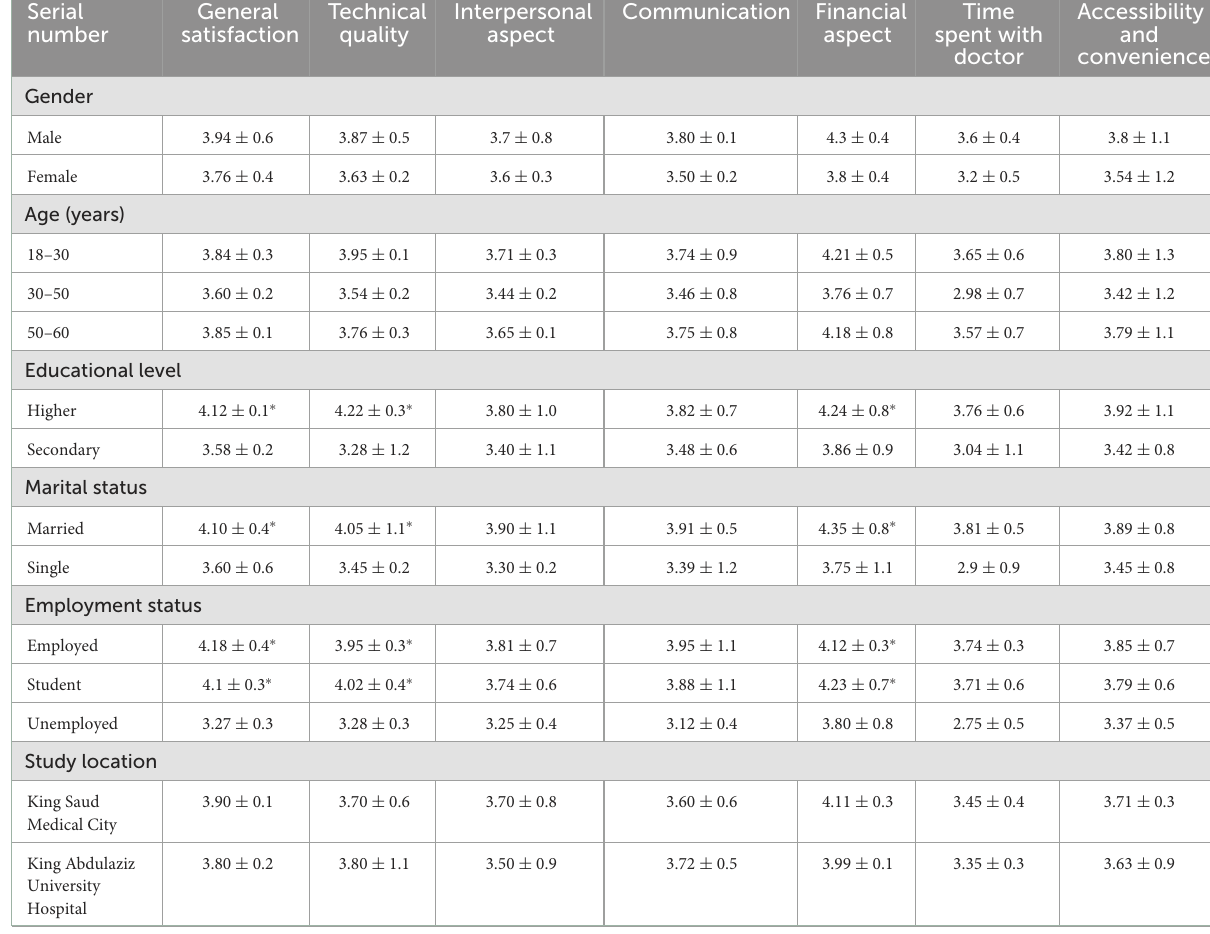
TABLE 4 Comparison of PSQ-18 subscales with sociodemographic